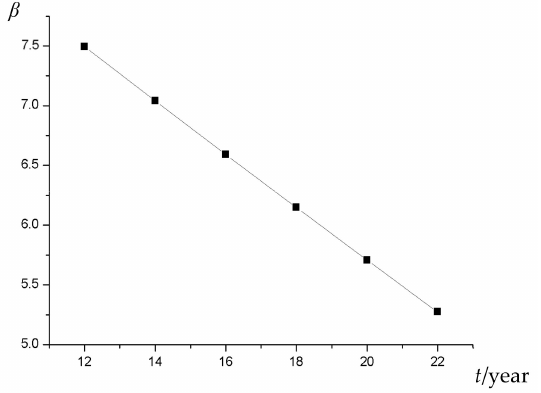
Figure 14. Non-probabilistic time-varying system reliability